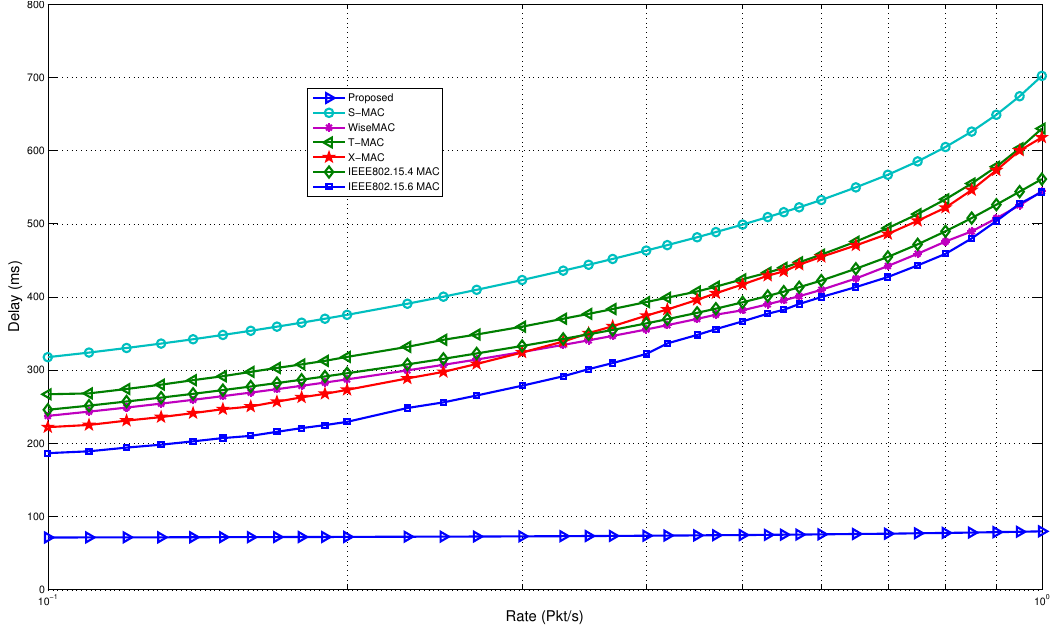
Figure 30. Impact of overhead on delay.